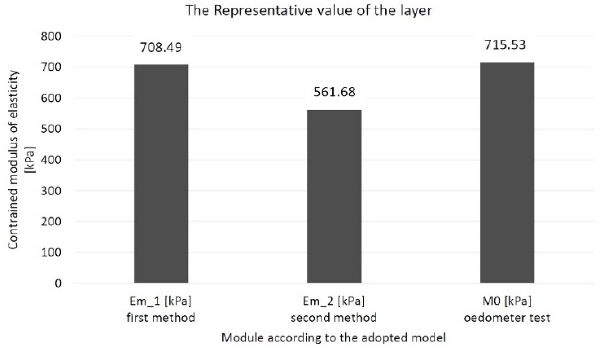
Figure 25. The representative values of the constrained modulus of elasticity for the peat layer according to the method used.